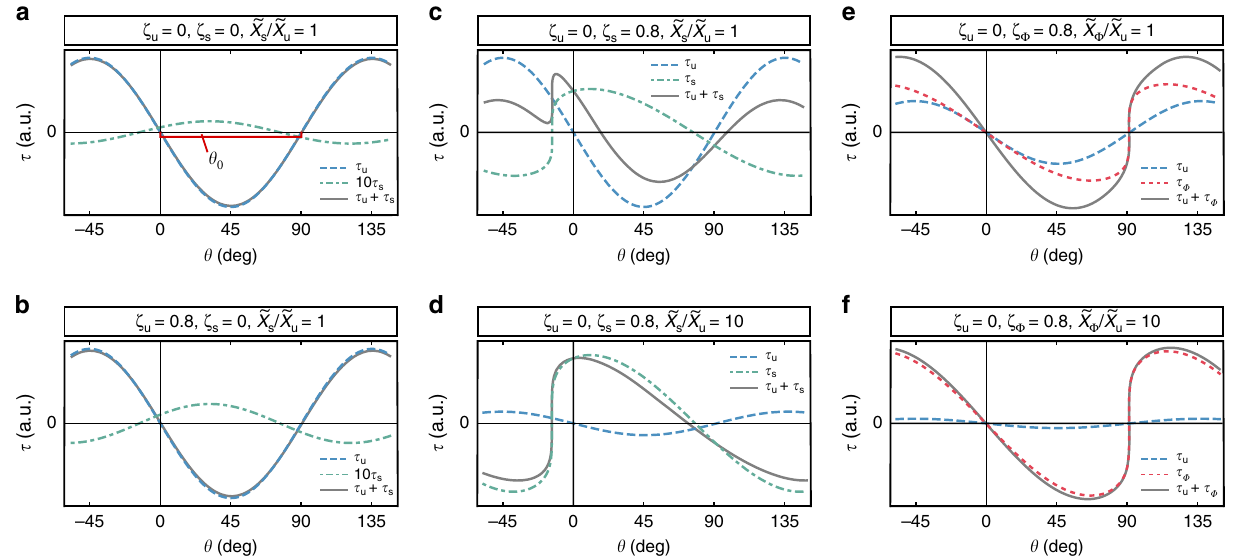
Fig. 2 Bulk torque angle dependence in critical scenario. Indicated parameter sets distinguish between uniform ( ζ u ≠ 0), staggered ( ζ s ≠ 0) and chiral ( ζ Φ ≠ 0) criticality, with the susceptibility scaling exponent ζ x . The total bulk torque is illustrated with solid gray, the uniform with dashed light blue, the staggered with dotted dashed blue, and the chiral contribution with dotted green lines. a Conventional case with fi eld-independent susceptibility. b Diverging uniform susceptibility ( ζ u = 0.8), dominated only by the uniform contribution. c Saw-tooth torque for diverging staggered susceptibility ( ζ s = 0.8) at intermediate fi eld ( ζ = ~ χ = ~ χ 0 : 8) at intermediate fi eld ( ~ χ ¼ 1). d Saw-tooth torque for diverging staggered susceptibility ( ζ s ¼ 0 : 8) at low- fi eld ( ~ χ ¼ 10). e Saw-tooth s ¼ s u s u torque for diverging scalar chiral susceptibility ( ζ Φ ¼ 0 : 8) at intermediate fi eld ( ~ χ Φ = ~ χ ¼ 1). f Saw-tooth torque for diverging scalar chiral susceptibility u